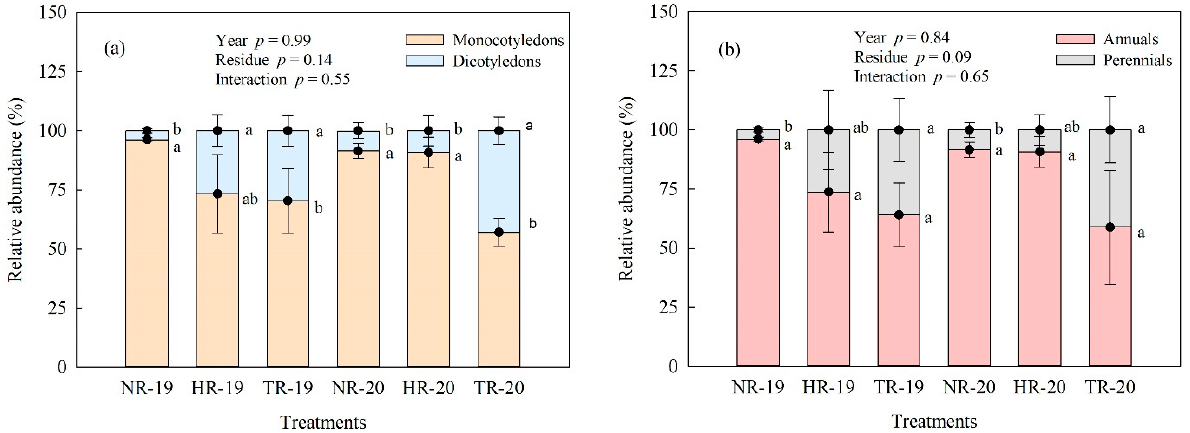
Figure 2. Relative abundance (%) of different morphological types ( a ) and life cycles ( b ) under treatments (NR-19—no crop residues retention in 2019; HR-19—half crop residues retention in 2019; TR-19—total crop residues retention in 2019; NR-20—no crop residues retention in 2020; HR-20—half crop residues retention in 2020) during the observation period. Different letters indicate significant differences at the 0.05 level between the treatments. Bars represent means ± SE. Statistical results above the bars show the linear mixed-effects model.